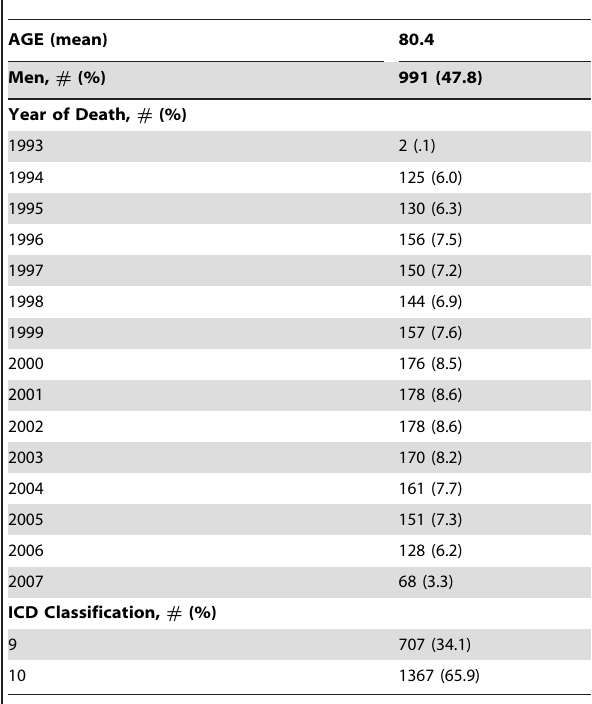
Table 1. Demographics of Study Cohort (N =2074).